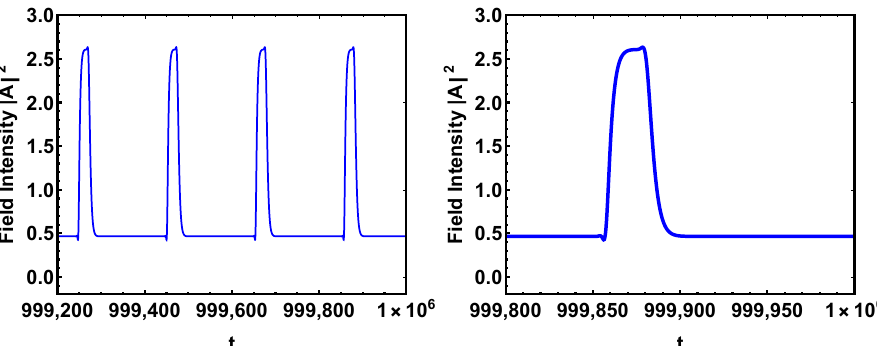
Figure 12. Periodic pulse train solution A ( t ) of (1) and (2) ( left ) and single pulse ( right ), where the parameters are γ 1 = 1, ω 1 ≈ 1.29, γ 2 ≈ 0.26, ω 2 ≈ − 0.034, κ l ≈ 0.68, φ ≈ − 4.17, η 0 ≈ 1.65, α = 1.5, T = 200. In the normalized Equation (12) these values correspond to σ = 3.23, β = 1, κ = 0.25, ϕ ≈ − 3.383, η =